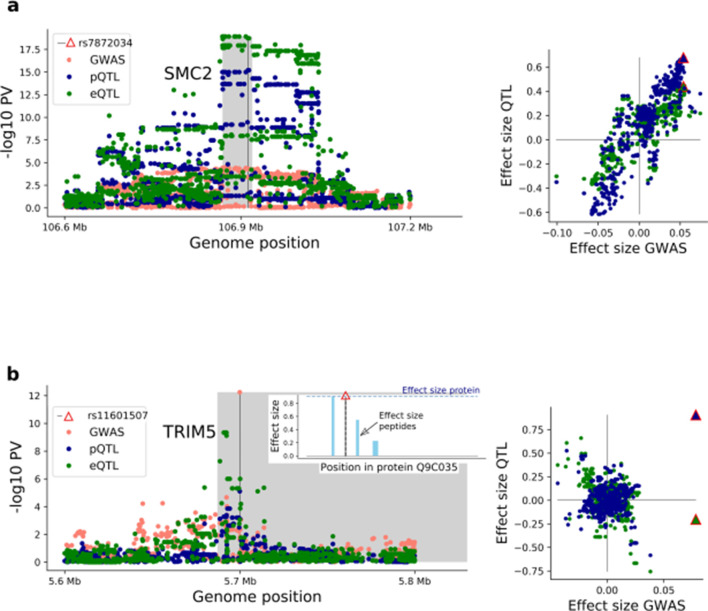
Example iPS eQTL and pQTL variance with evidence for co-localisation with GWAS variants.(a) Left - local Manhattan plot for the cis region of gene SMC2 (lead pQTL rs7872034), displaying eQTL and pQTL association negative log p-values, as well as negative log p-values obtained from a GWAS of invasive ovarian cancer (Phelan et al., 2017) (pQTL cumulative co-localisation posterior probability 0.8; eCAVIAR). Right: scatter plot with eQTL and pQTL effect sizes (y-axis) juxtaposed with effect sizes on invasive ovarian cancer (x-axis). The red triangle indicates the lead pQTL for protein and mRNA effects. (b) Local Manhattan plot of the cis region for the gene TRIM5 (lead pQTL missense variant rs11601507) displaying eQTL and pQTL association negative log p-values, as well as negative log p-values obtained from a GWAS study for coronary artery disease risk (van der Harst and Verweij, 2018). Right: scatter plot with eQTL and pQTL effect sizes juxtaposed with effect sizes on coronary artery disease risk. Left plot insert shows the position in Q9C035, the protein encoded by TRIM5, of the missense variant rs11601507 and of the peptides used for protein quantification.